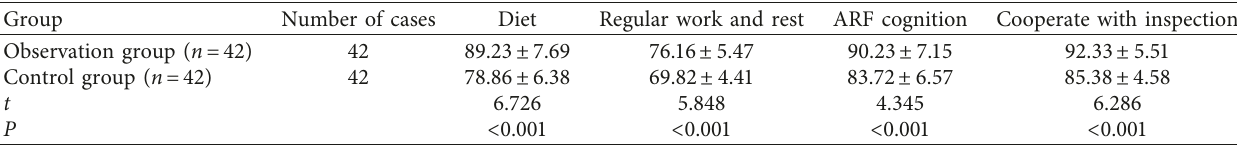
Table 4: Comparison of medical compliance behavior between the observation group and the control group (score, x ± s ).